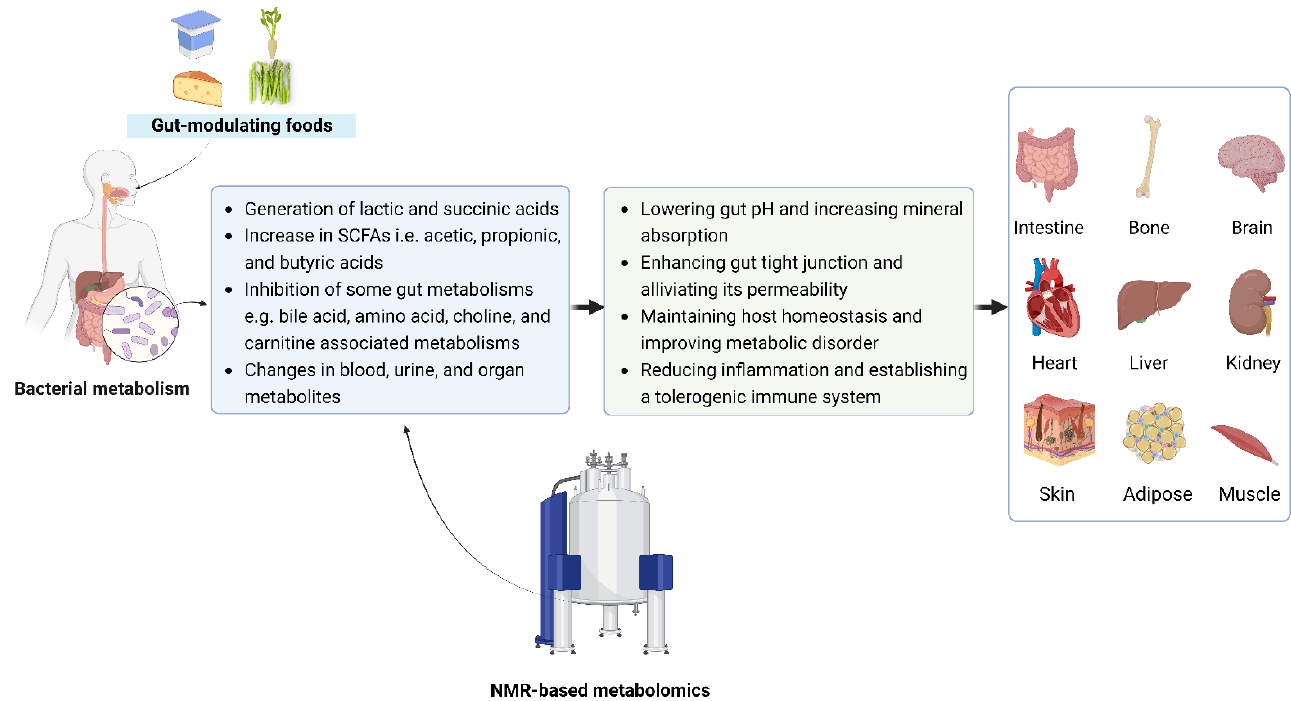
Figure 2. Metabolomics reveals metabolites as potential links between gut-modulating food and different organs, including intestine, bone, brain, heart, liver, kidney, skin, adipose, and muscle [49–51]. Figure created with Biorender.com